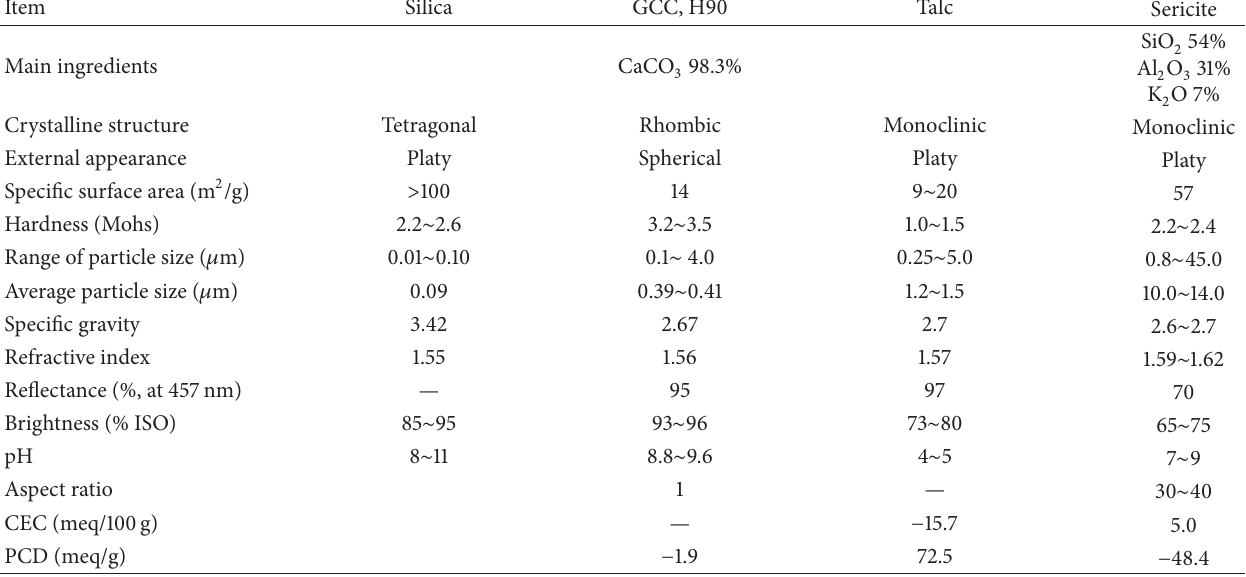
Table 1: Physical properties of the 4 pigments investigated [12, 13].